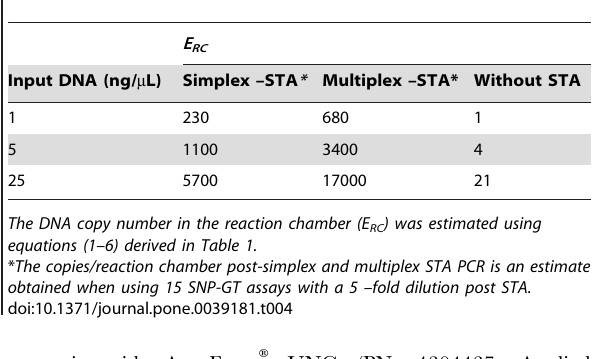
Table 4. Estimated DNA copy number in the reaction chamber with (simplex or multiplex) and without STA using whale genomic